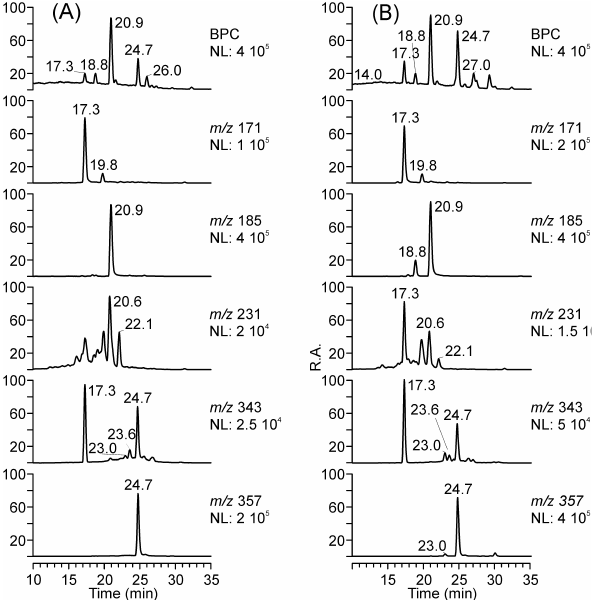
Fig. 1. LC/MS chromatographic data (base peak chromatograms – BPCs – and extracted ion chromatograms – EICs) for (A) α -pinene and (B) β -pinene ozonolysis SOA. Abbreviation: NL, normaliza- tion level. EICs are presented for m/z 171 (terpenylic acid and iso- baric compounds) m/z 185 ( cis -pinic acid and isobaric compounds), m/z 231 (diaterpenylic acid acetate and isobaric compounds), m/z 343 (MW 344 non-covalent and covalent dimeric compounds) and m/z 357 (MW 358 dimeric compounds).